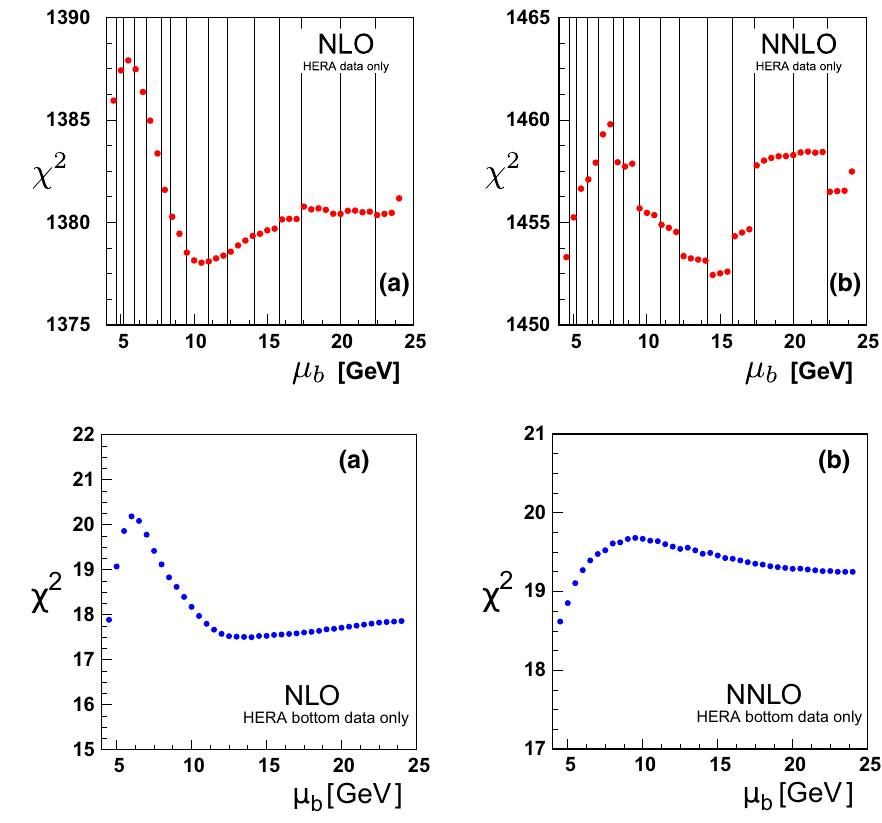
Fig. 8 χ 2 vs. the bottom matching scale μ b at a NLO and b NNLO for only the bottom data; note, this includes the H1 and ZEUS beauty data as well